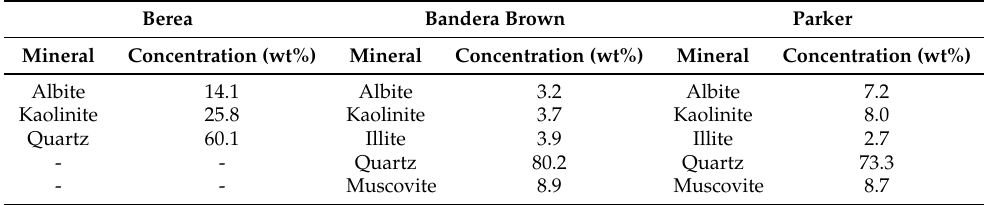
Table 3. Mineralogical composition of Berea, Bandera Brown, and Parker sandstones. Berea Bandera Brown Parker Mineral Concentration (wt%) Mineral Concentration